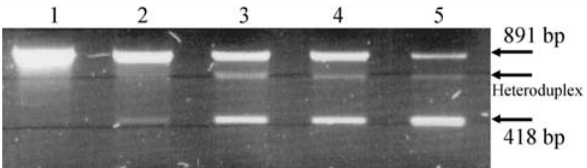
Figure 3 - GH cDNA and β -actin cDNA amplicons separated by 2% agarose gel electrophoresis. Lane M: 100-bp DNA molecular weight markers; Lanes 1, 3, 5, 7, and 9: RT-PCR reactions for the GH (418-bp) and β -actin (264-bp) genes with no RNase-free DNAseI-treated RNA; Lanes 2, 4, 6, 8, and 10: PCR reaction with total RNA as template for genomic DNA contamination control.